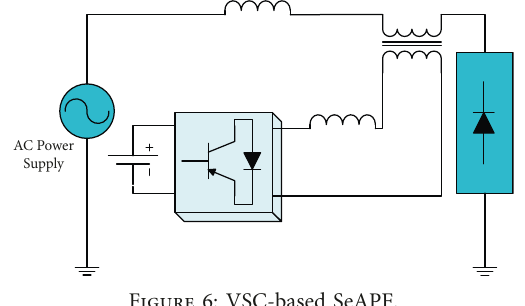
Figure 6: VSC-based SeAPF.